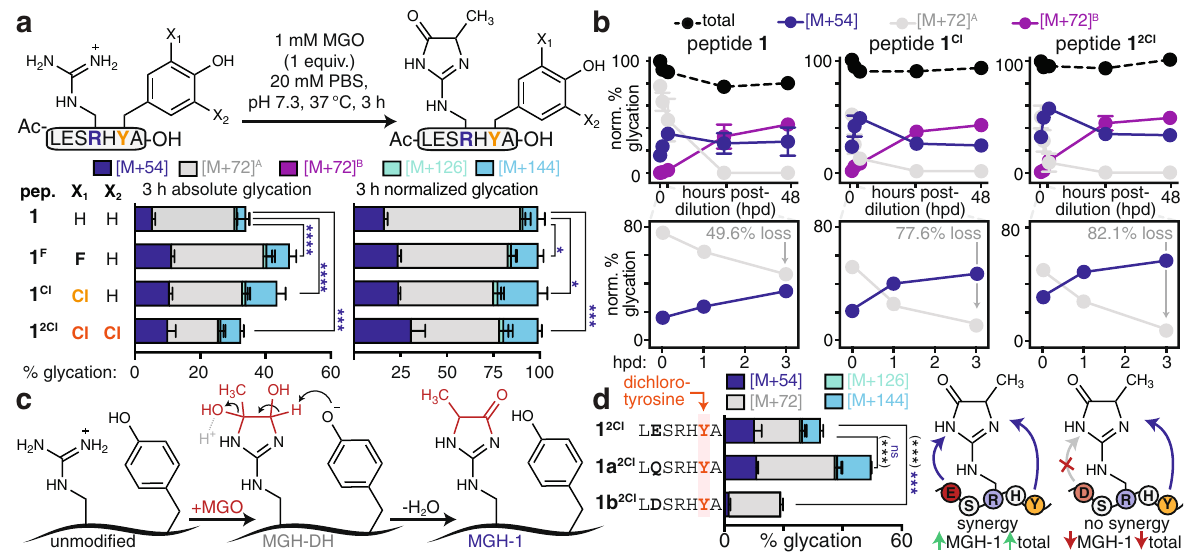
Fig. 6 Tyr plays an active mechanistic role and works cooperatively with Glu to favor MGH-1. a The role of the tyrosine phenol was evaluated by replacing Tyr (pK a = 10) with 3- fl uoro-Tyr (pK a = 8.2, 1 F ), 3-chloro-Tyr (pK a = 8.1, 1 Cl ), or 3,5-dichloro-Tyr (pK a = 6.2, 1 2Cl ) and then performing in vitro glycation. Absolute (left) and proportional (right) distribution of AGEs. Stacked bar graphs are plotted as mean values ± standard deviation, derived from independent experiments: peptide 1 , n = 8; 1 F , n = 3; 1 Cl , n = 3; 1 2Cl , n = 3. Legend: blue, [M + 54]; gray, [M + 72] A ; purple: [M + 72] B ; green, [M + 126]; cyan, [M + 144]. Individual data points are shown in Supplementary Fig. 21. b Glycation adducts observed for peptides 1 , 1 Cl , and 1 2Cl upon dilution after 3